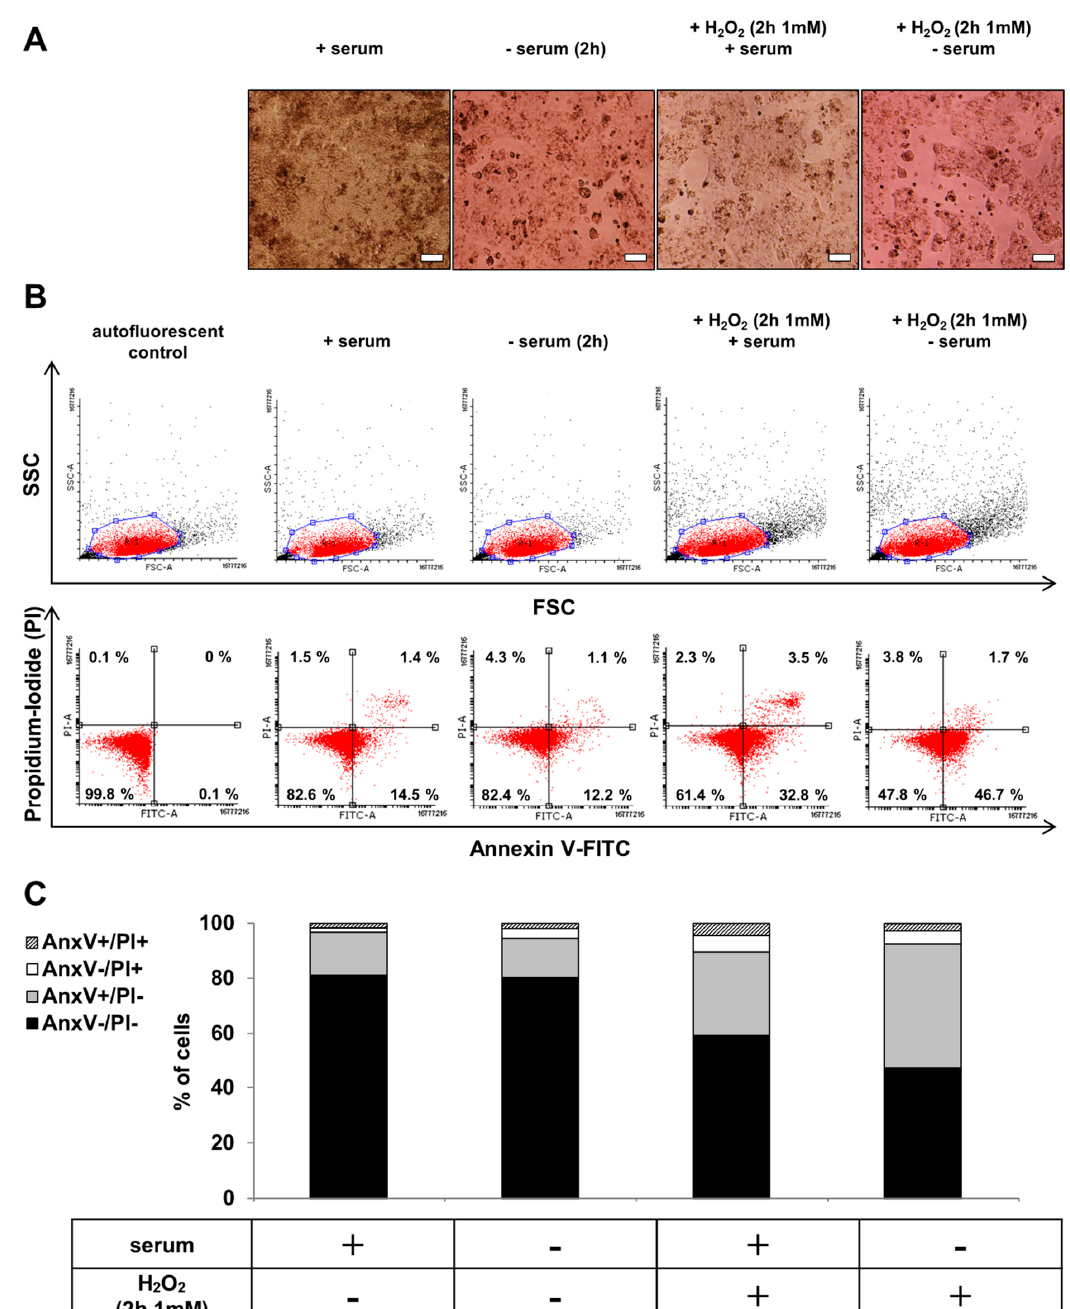
shows the intensity of staining for PI (log scale). The numbers in the quadrants indicate the percentage of different cell populations. Cells in the lower left quadrant (AnxV − /PI − ) are viable, those in the lower right quadrant (AnxV + /PI − ) are early apoptotic, those in the upper left (AnxV − /PI + ) are necrotic and those in the upper right (AnxV + /PI + ) are late apoptotic cells. Data are representative of 3 independent experiments. ( C ) The bar charts indicate the average percentage of AnxV − /PI − (black bars), AnxV + /PI − (grey bars), AnxV − /PI + (white bars) and AnxV + /PI + (striped bars) cells from 3 independent experiments. Int. J. Mol. Sci. 2018 , 19 , x FOR PEER REVIEW